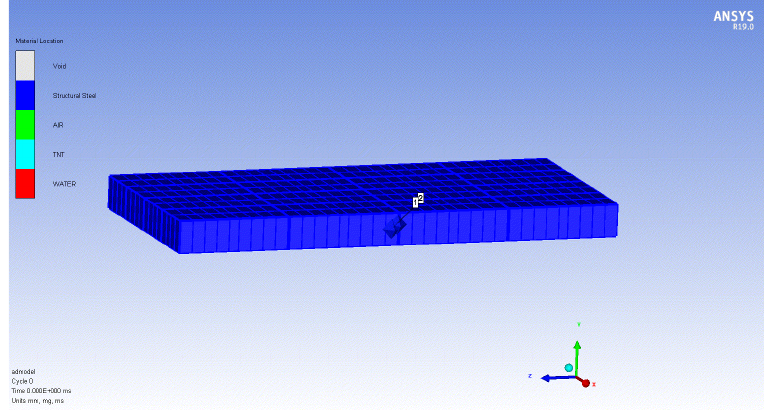
Figure 5. Gauges for the side explosion.